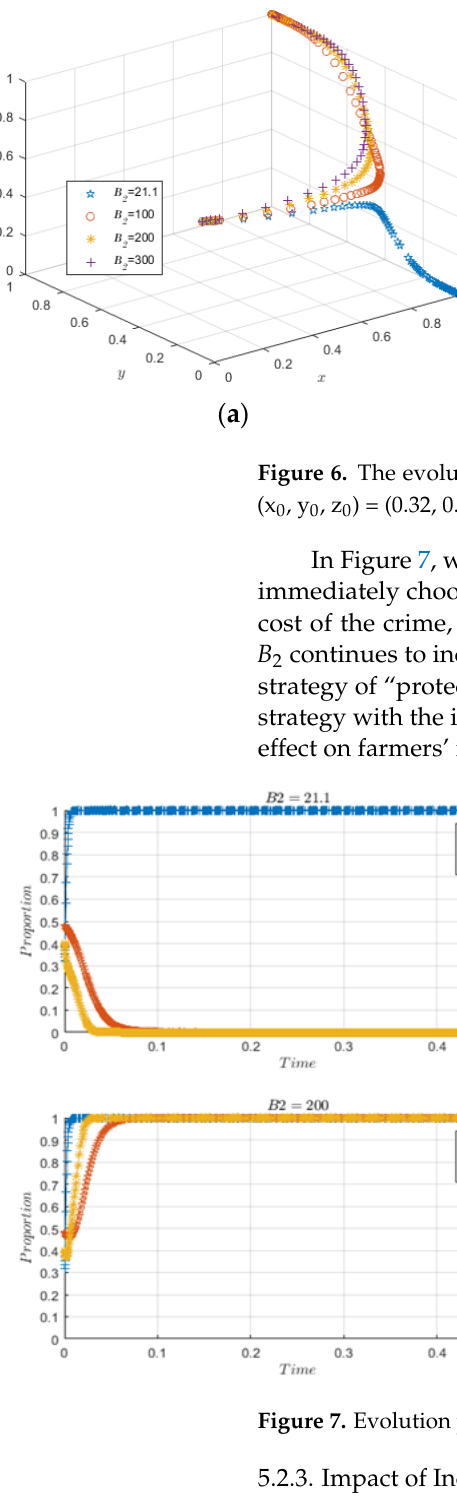
Figure 7. Evolution path of each stakeholder in System A under different farmers’ fines.